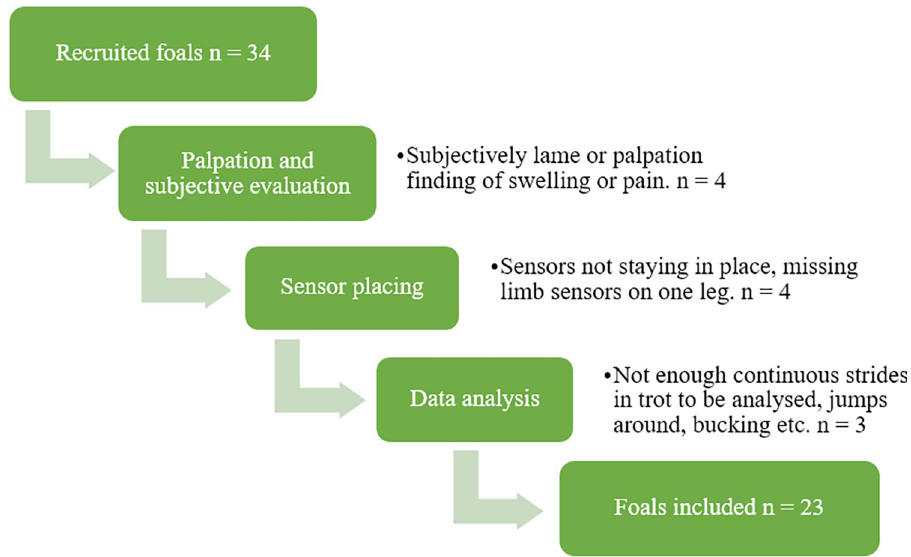
Fig 1. Exclusion flowchart for Standardbred foals after recruitment, with number (n) of foals excluded in each section and cause of exclusion.